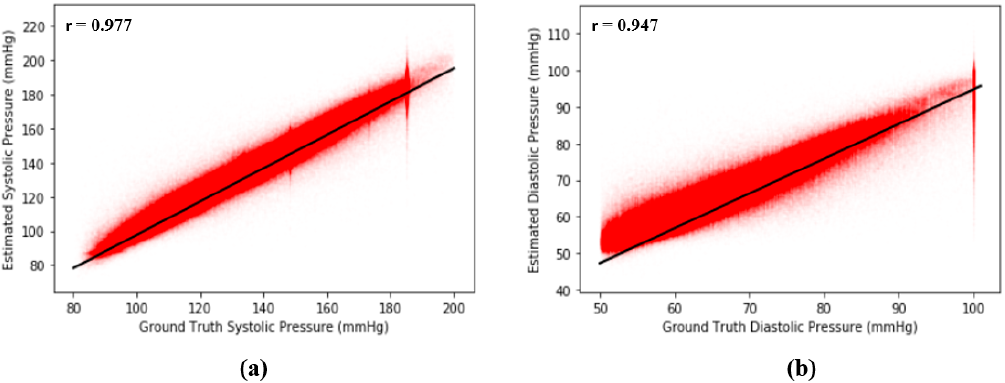
Figure 12. ( a ) Pearson’s correlation analysis results for error across 2,176,188 records of SBP and ( b ) Pearson’s correlation analysis results for error across 2,176,188 records of DBP.